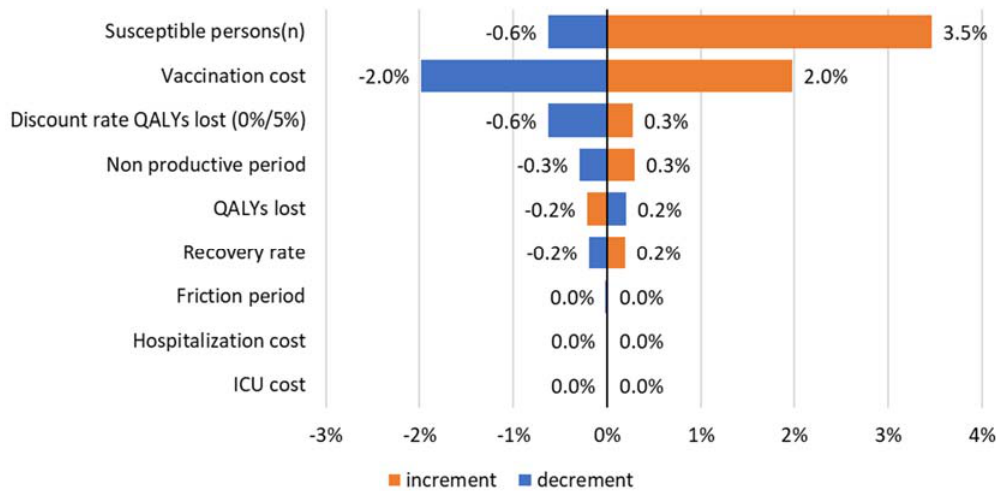
Figure 5. Sensitivity analysis from a societal perspective (+/ − 10%; except for discount rate QALYs lost at 0% and 5%).